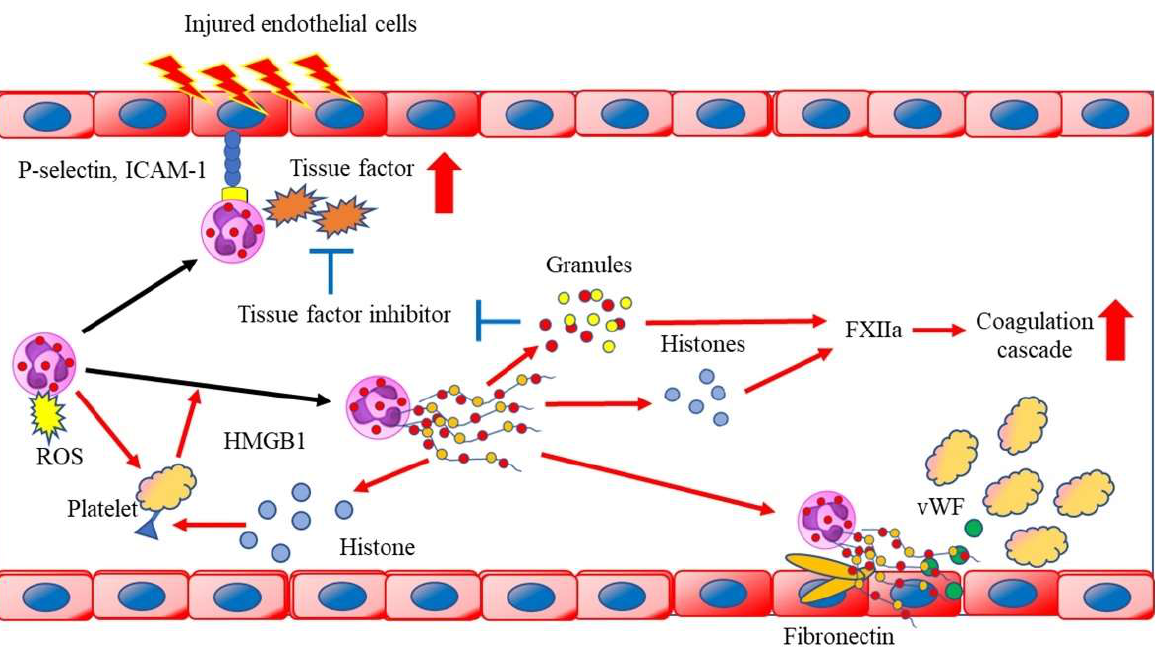
Figure 2. Neutrophils activate platelets through the production of reactive oxygen species (ROS) and the activated platelets present high mobility group box 1 to neutrophils and induce neutrophil extracellular trap (NET) formation. NETs bind to FXIIa and tissue factor (TF), causing the activation of the coagulation cascade. Neutrophil-derived granules degrade the TF pathway inhibitors.